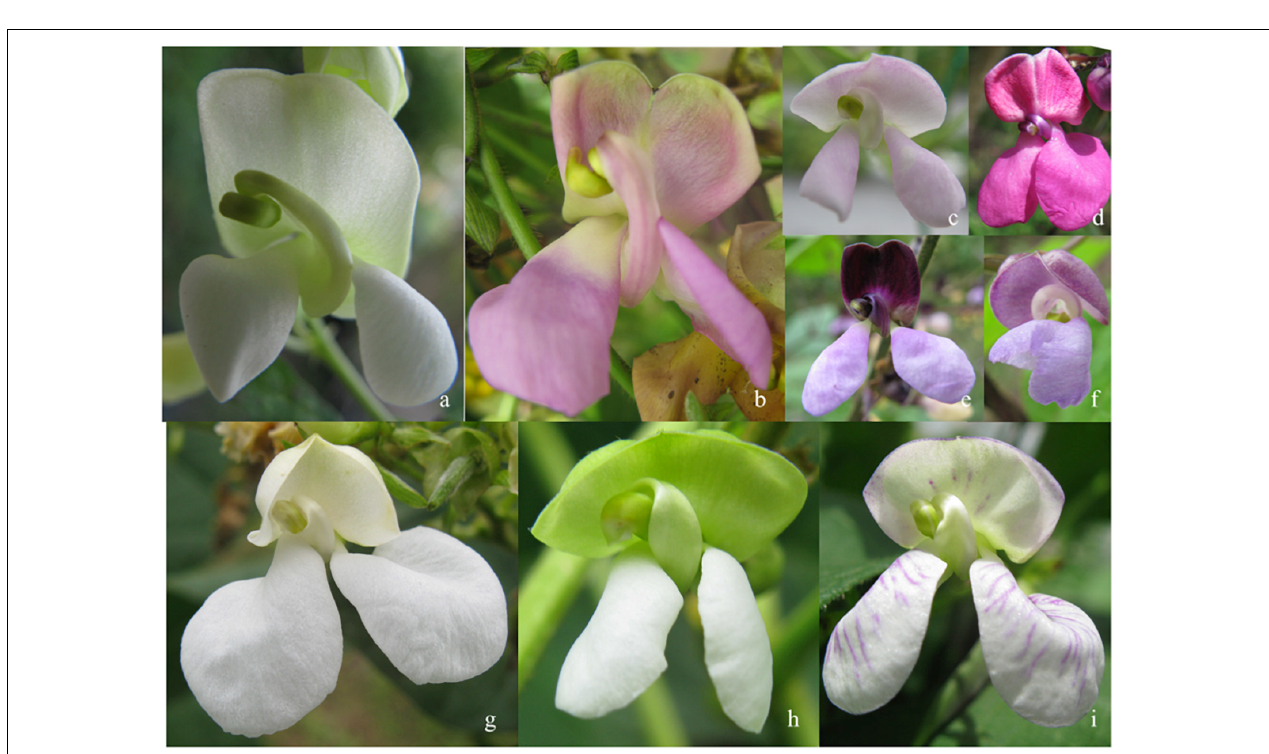
FIGURE 3 | (a) Phaseolus albiflorus . (b) P. chiapasanus . (c) P. acutifolius . (d) P. talamancensis . (e) P. augusti . (f) P. xanthotrichus . (g) P. dumosus . (h) P. lunatus . (i) P. vulgaris (photographs taken by D.G.